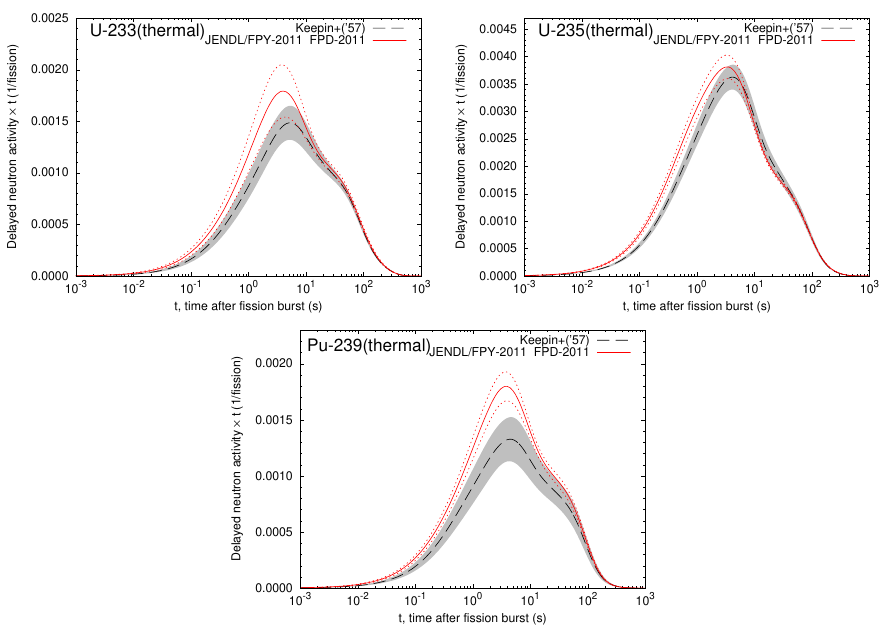
Figure 1. Delayed neutron activities for thermal neutron induced fission for 233 , 235 U and 239 Pu multi- plied by time ( t ). In the panels, the results of Keepin’s six group evaluation [12] (the dashed line) and the summation calculation by using JENDL / FPY-2011 and JENDL / FPD-2011 (the solid line) are shown. Errors of Keepin’s six group are shown by the shaded area, while the uncertainties of the summation calculation are shown with the dotted